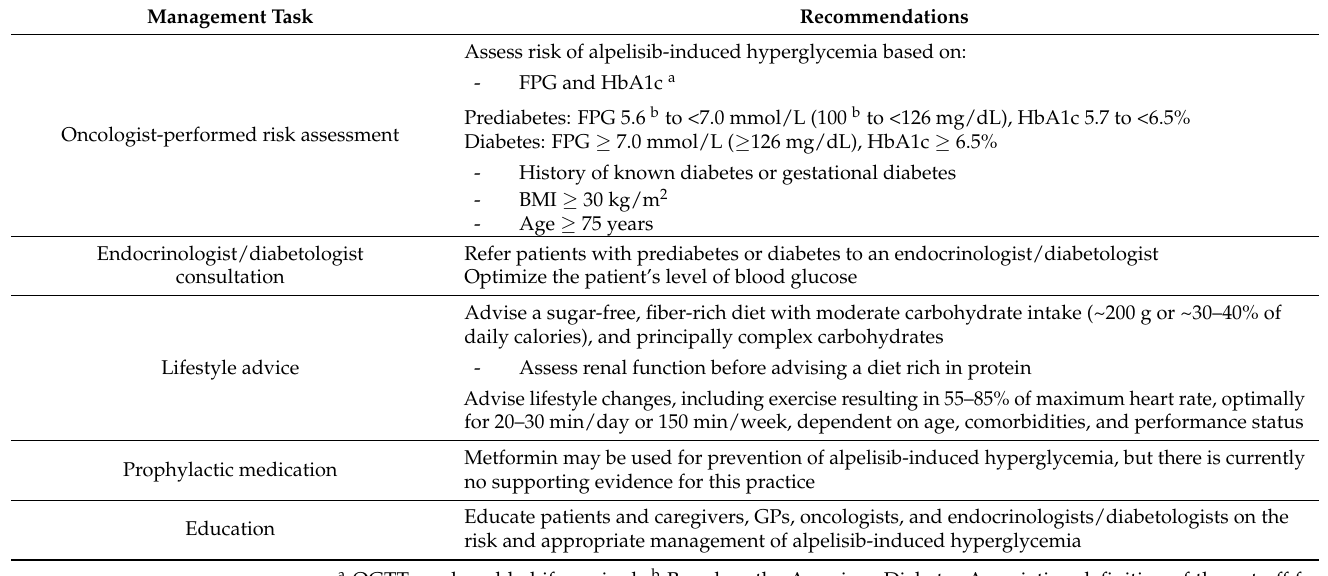
Table 1. Recommendations for preventive hyperglycemia management in patients scheduled to receive